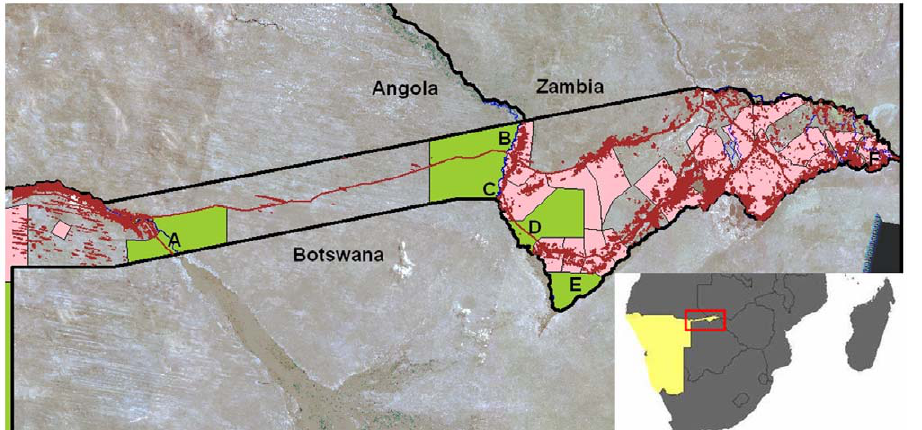
Figure 1. The study area and buffalo GPS locations. The study area was the Caprivi Strip of Namibia, with GPS locations of n =31 collared animals (different colours indicate different individuals). In addition, green indicates protected areas, pink areas are communal conservancies, and brown lines indicate major roads. Capture sites are (A) Mahango National Park/Buffalo Core Conservation Area; (B) Susuwe; (C) Horseshoe; (D) Mudumu National Park; (E) Mamili National Park; (F) Eastern Floodplains.